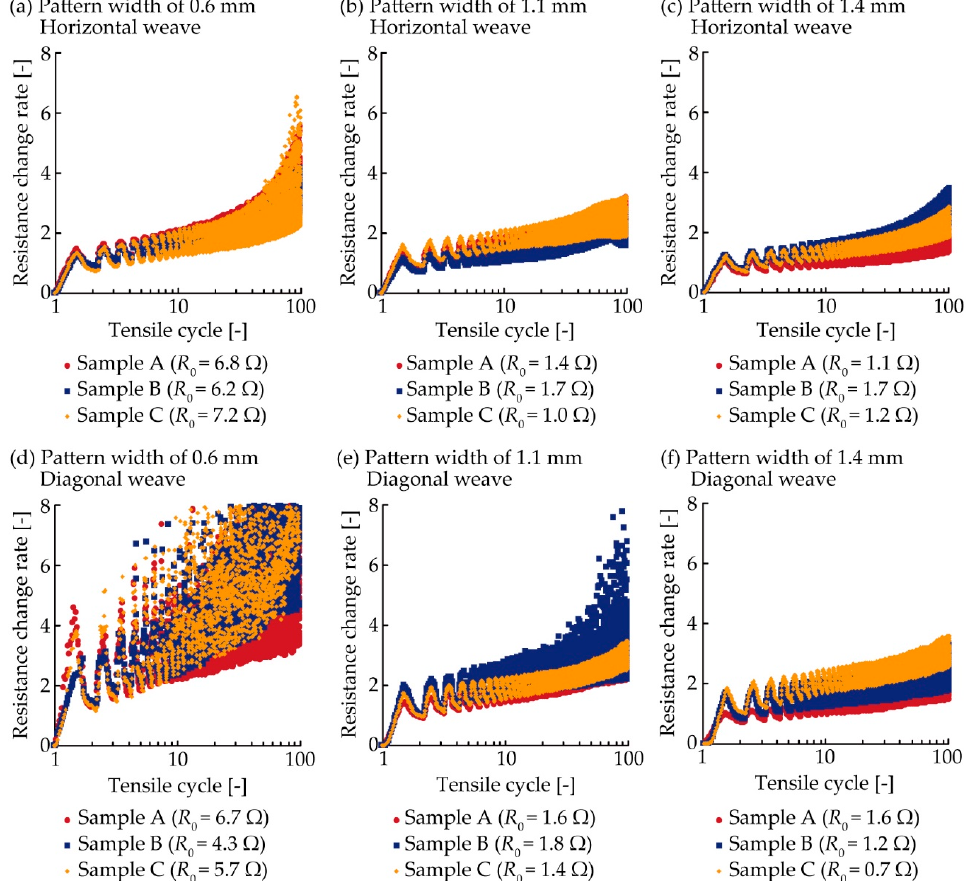
Figure 4. Resistance variation of conductive patterns printed on a plain weave under cyclic tensile deformation of 5%. ( a–c ) Pattern widths of 0.6, 1.1, and 1.4 mm with horizontal weave. ( d–f ) Pattern widths of 0.6, 1.1, and 1.4 mm with diagonal weave.